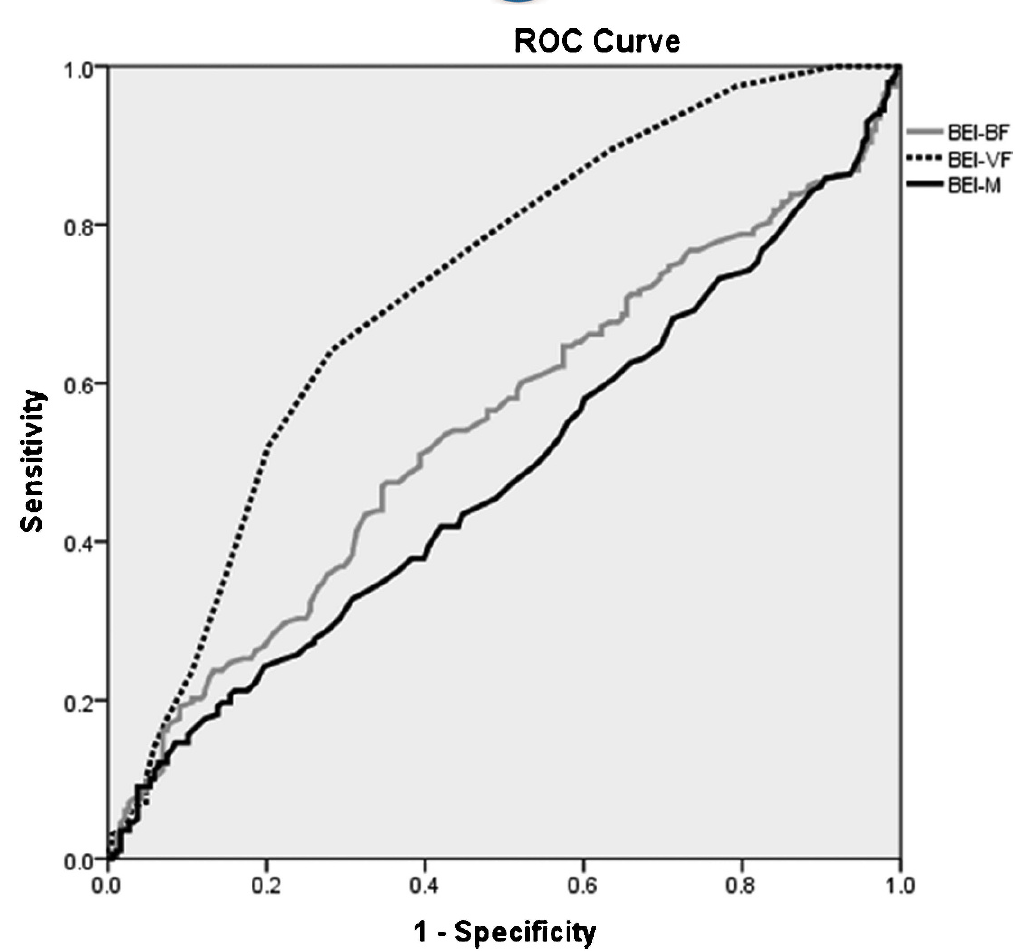
Figure 2 - Receiver-operating characteristic curves of body composition. BEI-BF: total body fat; BEI-VF: viseral fat; BEI-M: muscle.